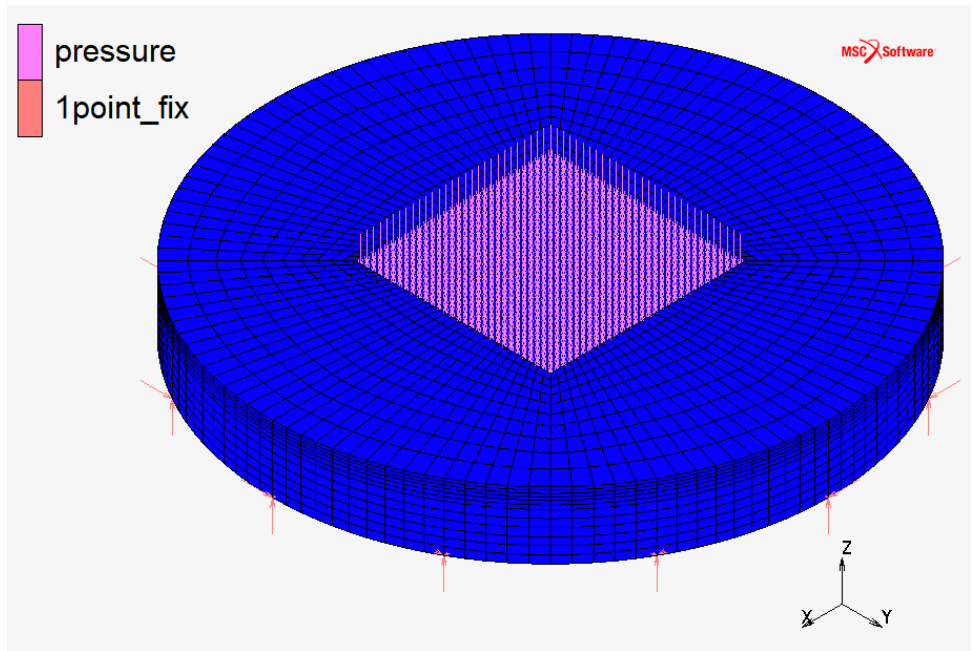
Figure 3. Monopolar plate—discretized domain in configuration “b”: circular plan view and squared active